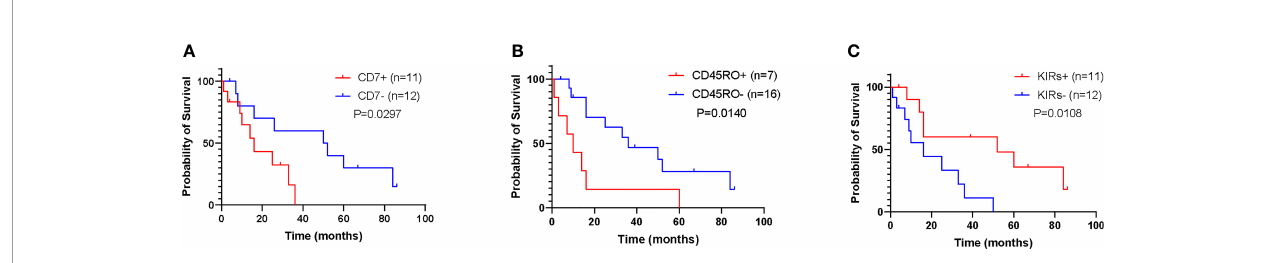
FIGURE 6 | Prediction of survival of ENKTL by immunophenotype (n = 23). (A) Effect of CD7 expression on survival time of patients. (B) Effect of CD45RO expression on survival time of patients. (C) Effect of expression of KIRs on survival time